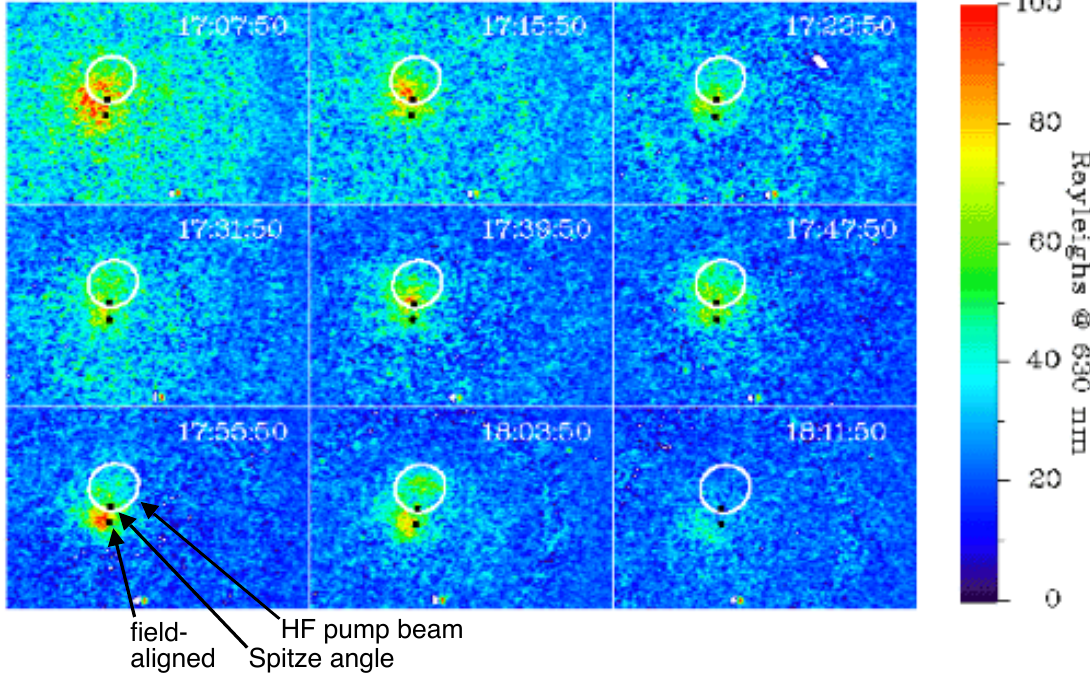
Fig. 5. Airglow at 630.0nm between the Spitze and geomagnetic field-aligned positions. These positions are indicated for 230-km altitude by the black squares; the circle indicates the half-power contour of the pump beam, which was centered on the zenith. Adapted from Kosch et al. (2000), Fig.